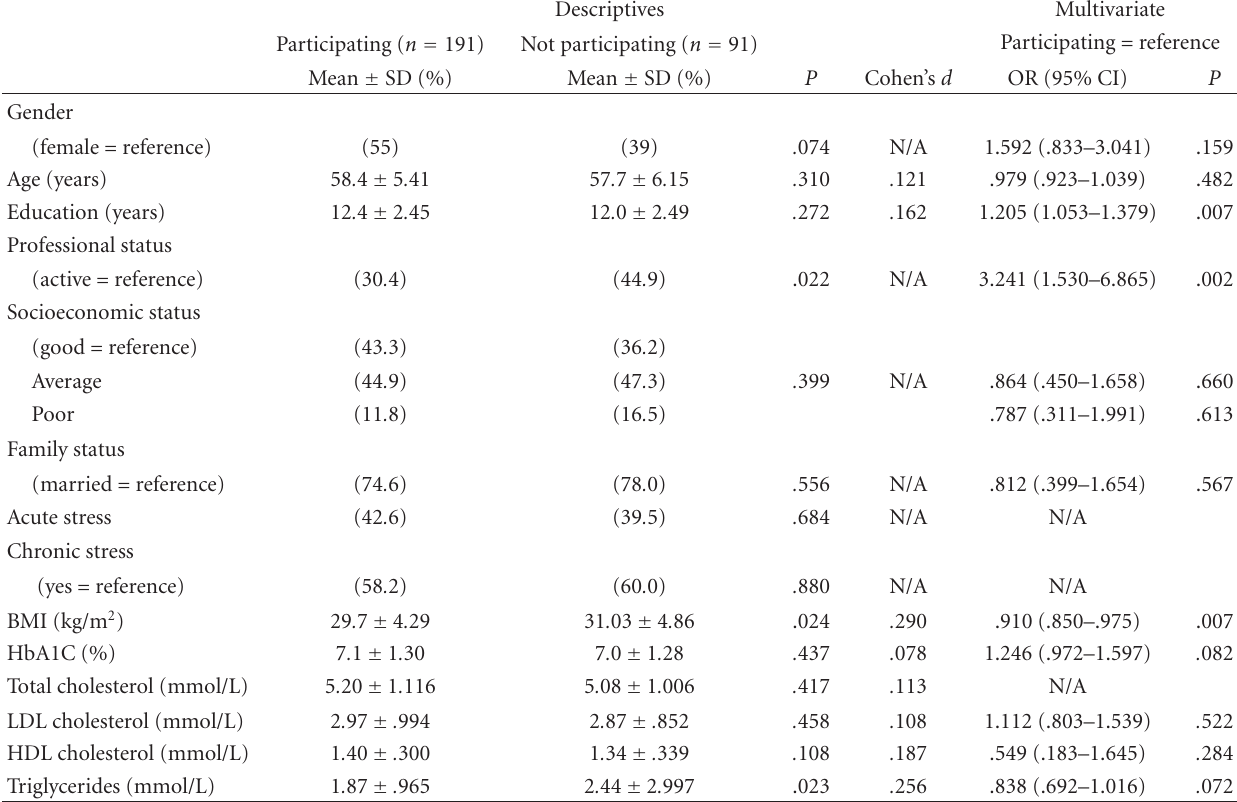
Table 2: Demographic and clinical variables in patients who accepted treatment and those who did